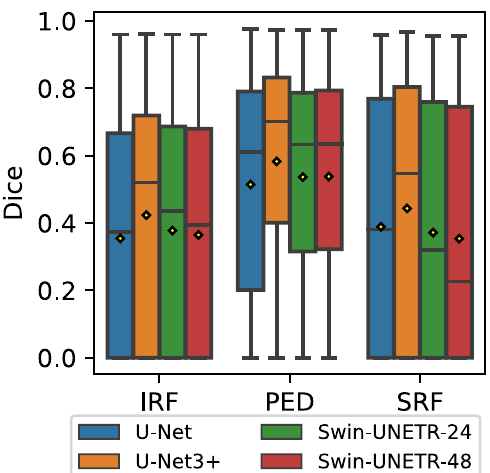
Figure 1. Boxplots of model comparison results per class for Dice score across the entire dataset. The boxes show the middle 50% of the values. Whiskers reach at most 1.5 times the interquartile range (= box height) on top of either end of the box. Points outside the whiskers are considered outliers and are not shown here. The horizontal bar within the box shows the median. The mean is depicted with a yellow diamond.